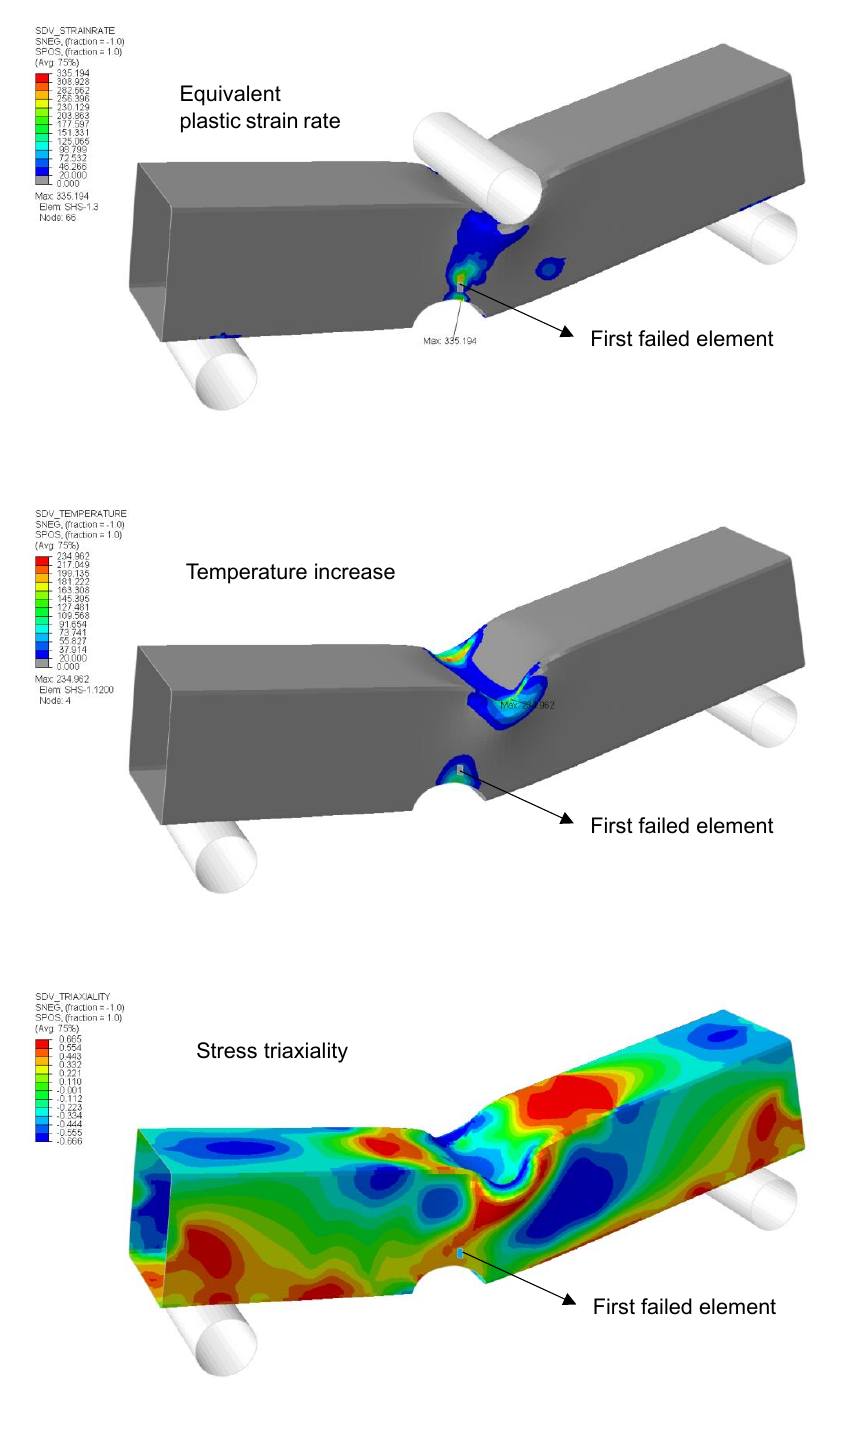
Figure 12. State variables at the initiation of